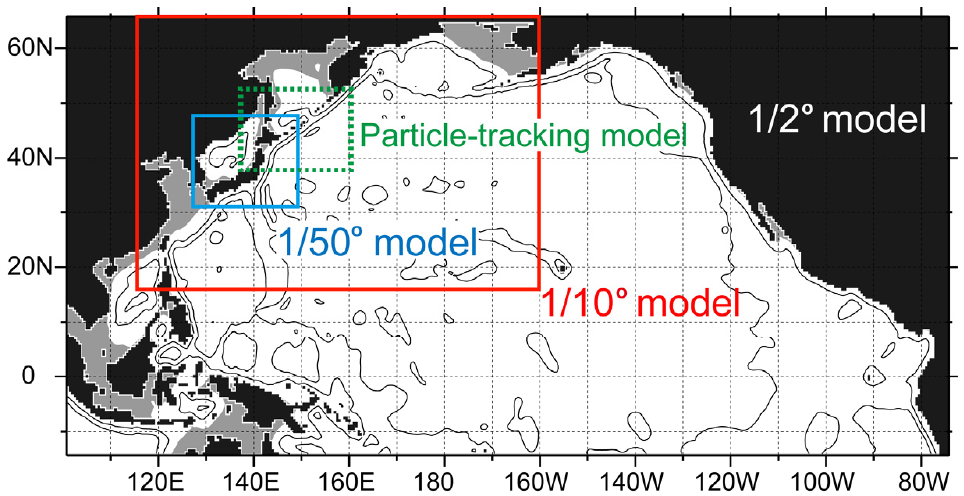
Figure 2. Domain of 1/2° eddy-permitting ocean model. The red and light-blue rectangles indicate the domain of the 1/10° and 1/50° eddy-resolving ocean model, respectively. For particle-tracking simulations, outputs from the 1/10° and 1/50° ocean models were combined within the green dashed box.